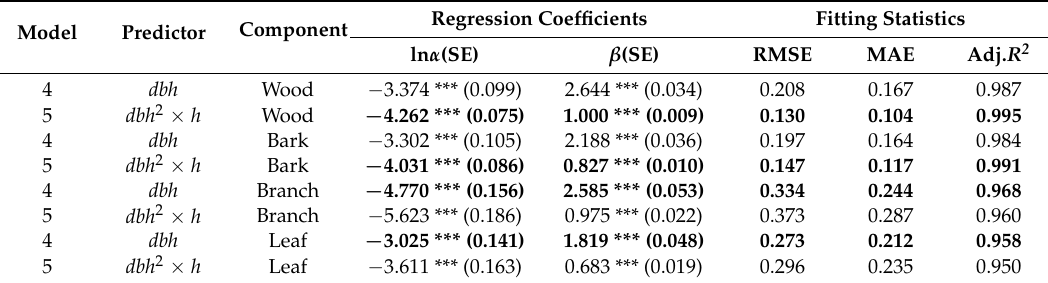
Table 4. Coefficients with standard error (SE) and goodness-of-fit statistics of the two systems of additive equations for the wood, bark, branch, and leaf components of the studied species through SUR methodology. α and β are model coefficients, while RMSE, MAE, and Adj. R 2 are the root mean square error, mean absolute error, and adjusted coefficient of determination.